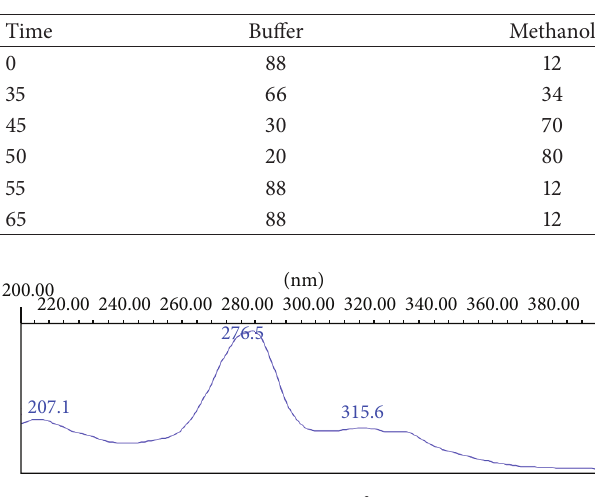
Table 5: Gradient program for developed method.